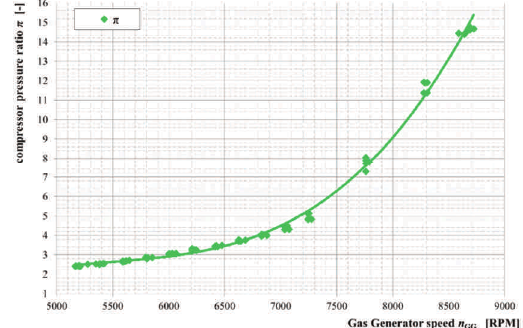
Fig. 10. Approximated function and the results of the measurements of compressor pressure ratio π , recorded for steady-state operation of LM-